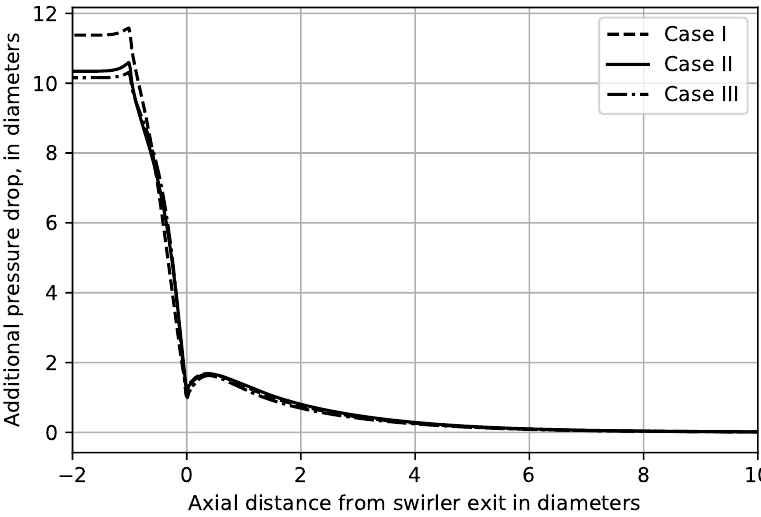
Figure 15. Pressure along the flow direction, expressed as length in number of diameters, but with the normal pressure drop in straight laminar flow subtracted.